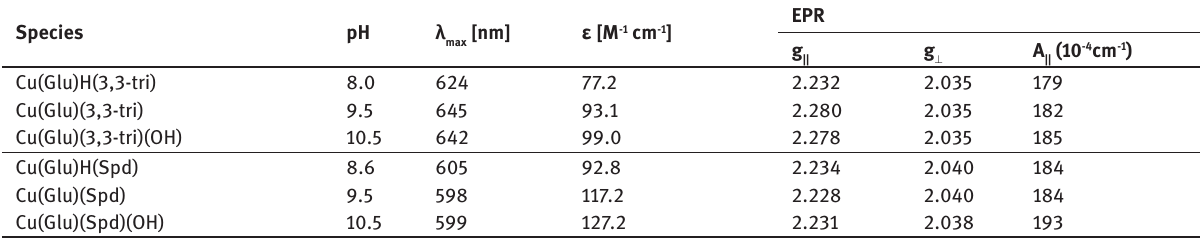
, 15.01(7); Cu(Glu) 2 , 18.48(24); Cu(3,3-tri)(OH), 3.14(5) [49]; CuH(Spd), 2